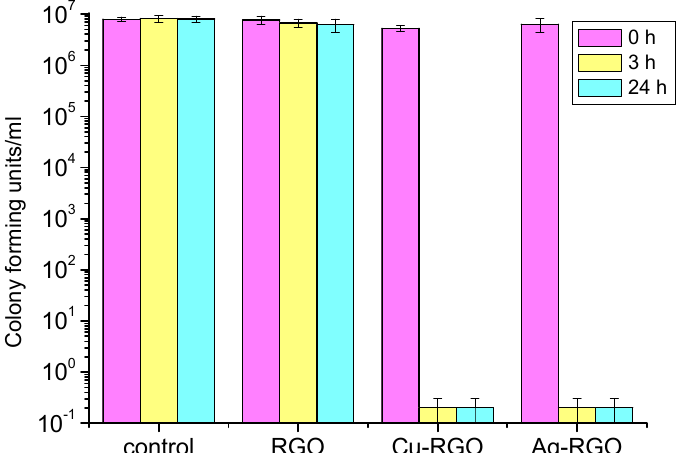
Figure 9. Survival of Escherichia coli bacteria after 0, 3 and 24 h treatment with RGO and metal–RGO composites.